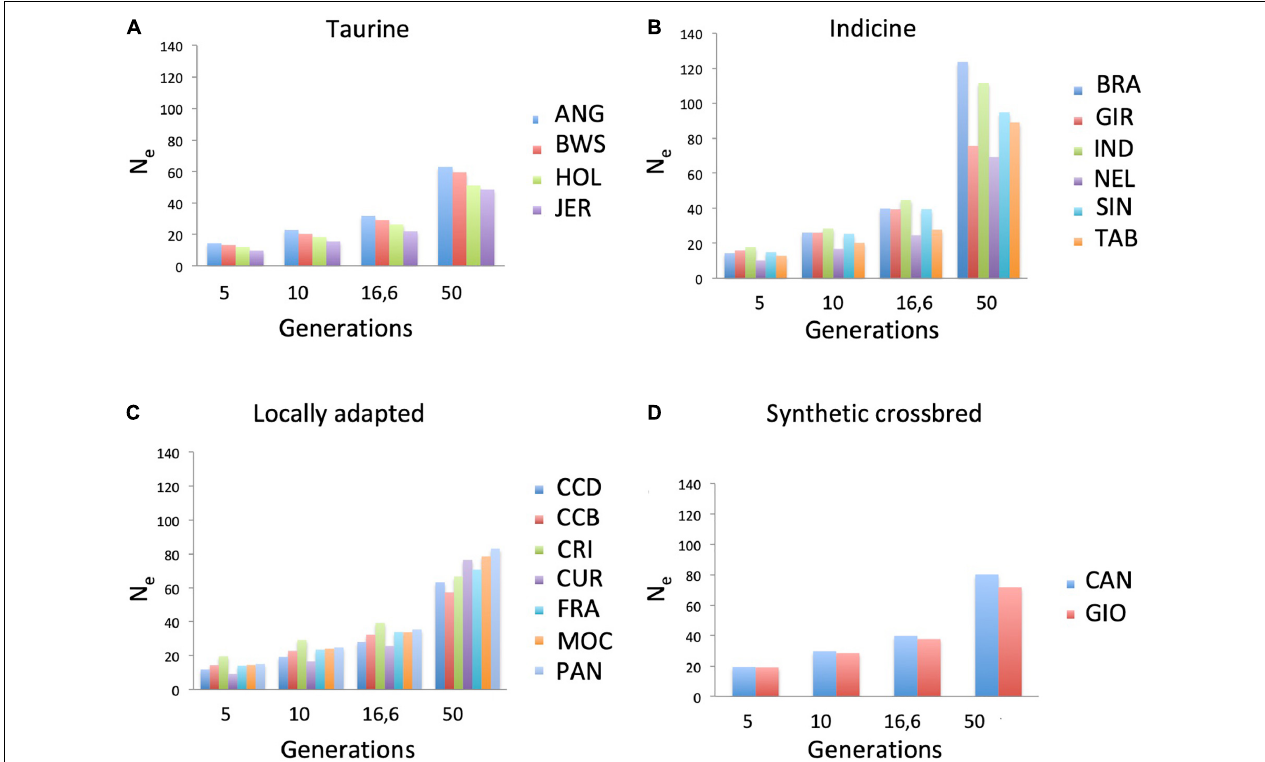
FIGURE 3 | Effective population size ( N e ) across four generations in nineteen cattle breeds raised in Brazil. Breeds are separated into (A) taurine, (B) indicine, (C) locally adapted, or (D) synthetic crossbred groups. ANG, Angus; BWS, Brown Swiss; JER, Jersey; HOL, Holstein; BRA, Brahman; GIR, Gir; IND, Indubrasil; NEL, Nelore; SIN, Sindhi; TAB, Tabapuã; CCD, Caracu Dairy; CCB, Caracu Beef; CRI, CriouloLageano; CUR, CurraleiroPé-Duro; FRA, CriouloLageano do RS; MOC, MochoNacional; PAN, Pantaneiro: CAN, Canchim; GIO,